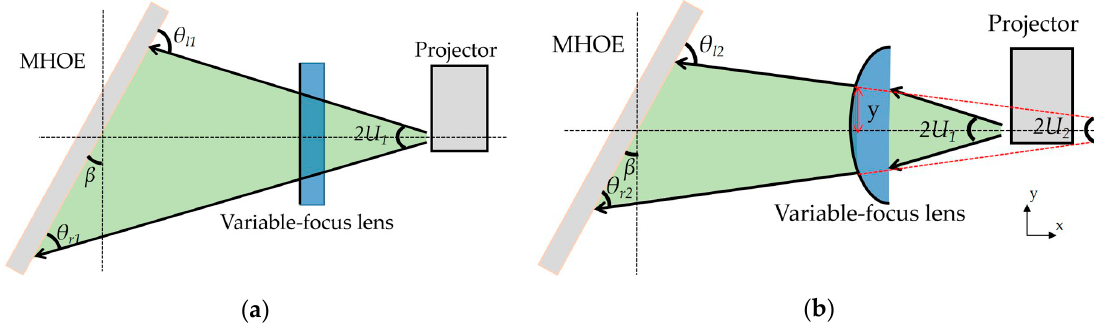
Figure 2. The projected beam matching with the Bragg matching angles under different diopters of the variable-focus lens: ( a ) 3D mode; ( b ) 2D